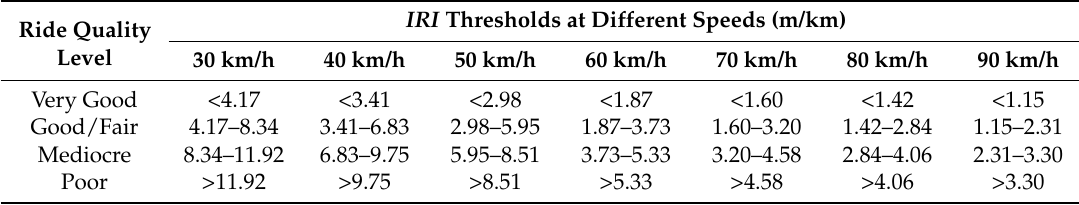
Table 6. IRI thresholds at different speeds suggested by Cantisani and Loprencipe